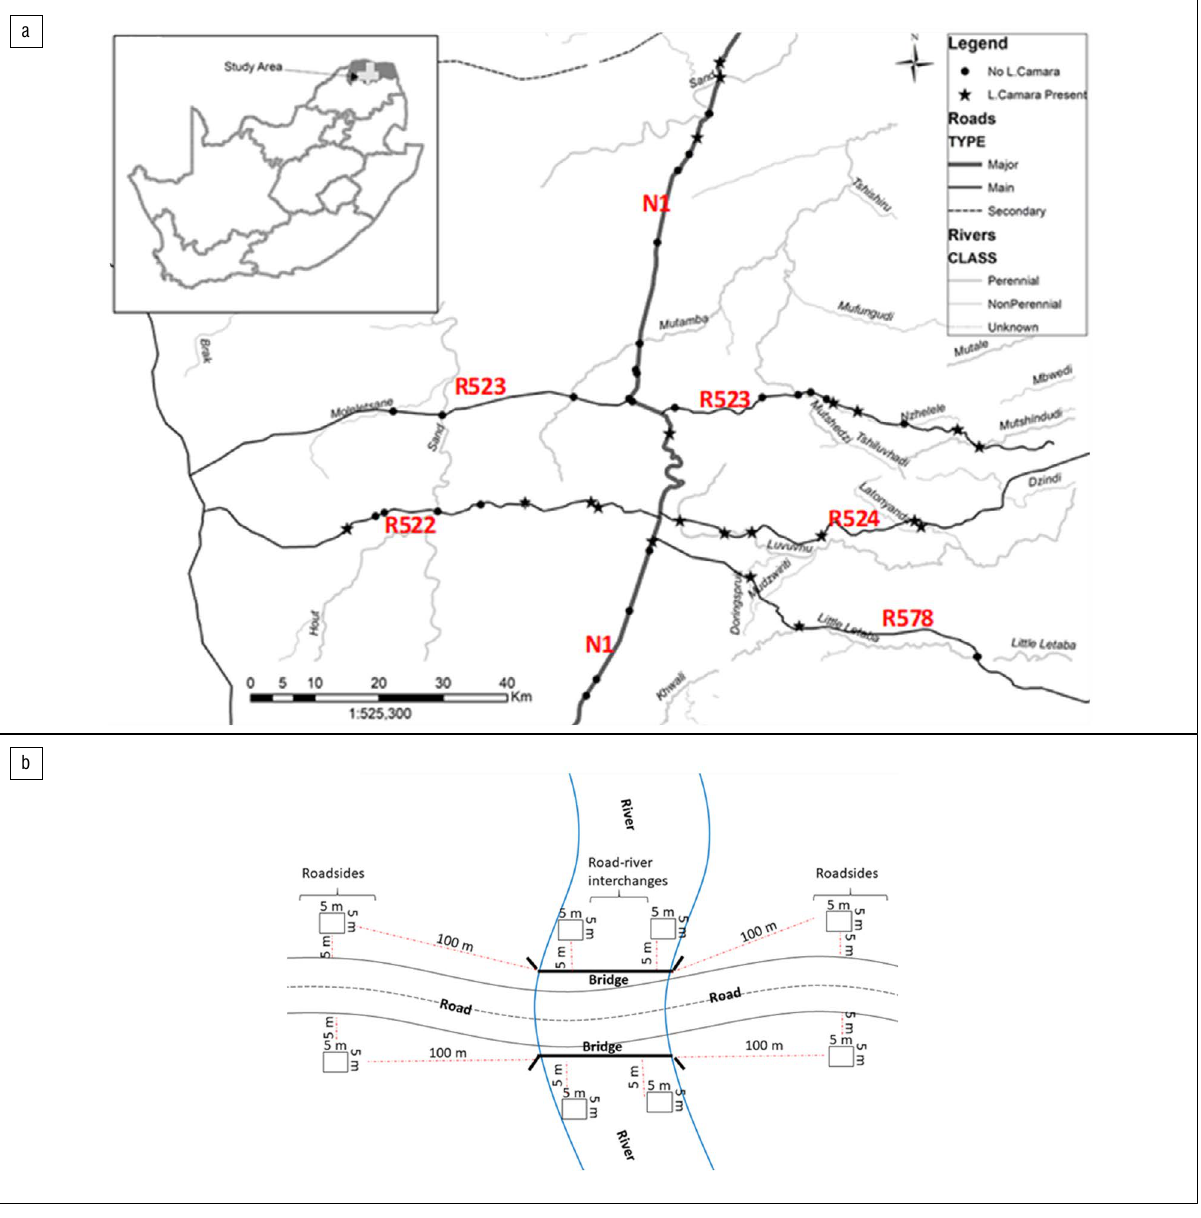
Figure 1: (a) Location of the study area in Vhembe Biosphere Reserve, Limpopo Province of South Africa with surveyed national and regional roads shown. (b) Schematic illustration showing how plots were sampled at different road